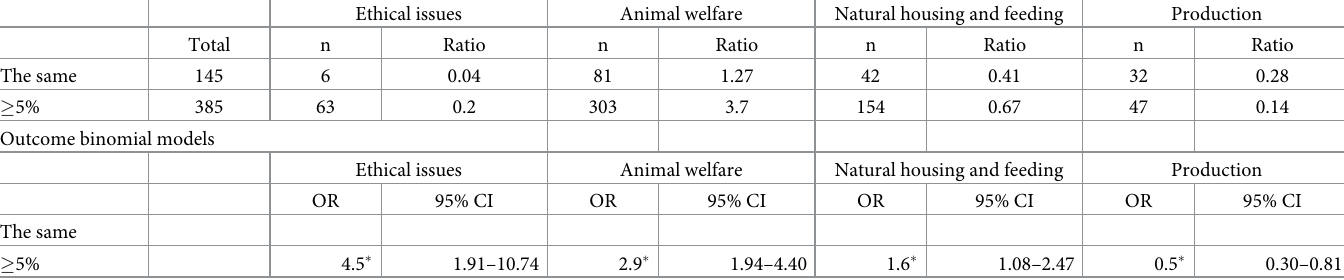
Table 5. The number and the ratio of participants asked about their WTP (cid:21) 5% to buy eggs produced in the conditions described as important and mentioned each of the emerging themes: Ethical issues, welfare, natural housing and feeding and production. Odds ratio and 95% confidence interval (95% CI) for binomial models of the type of egg participants usually buy and association with emerging themes are